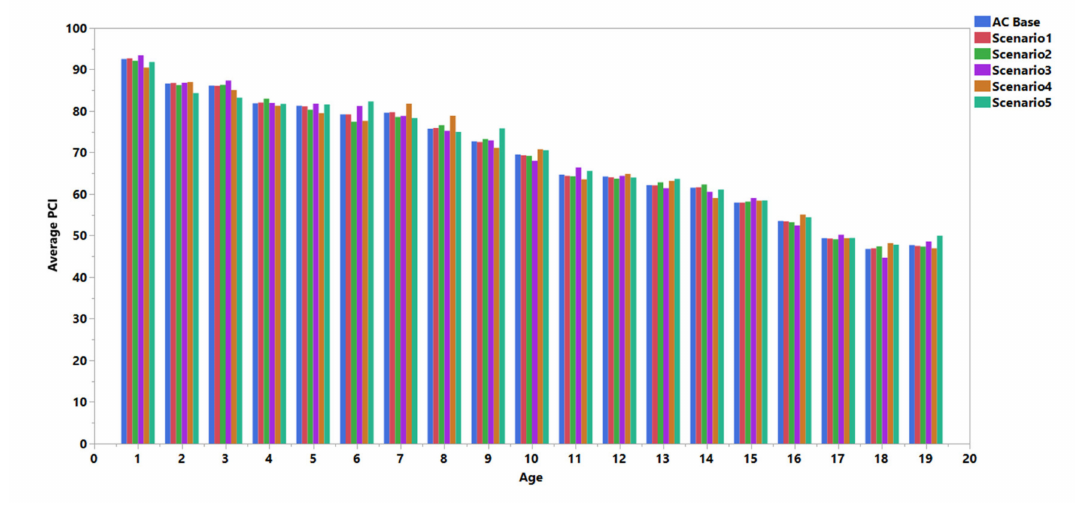
Figure 9. Weighted average PCI for AC pavements versus pavement age.